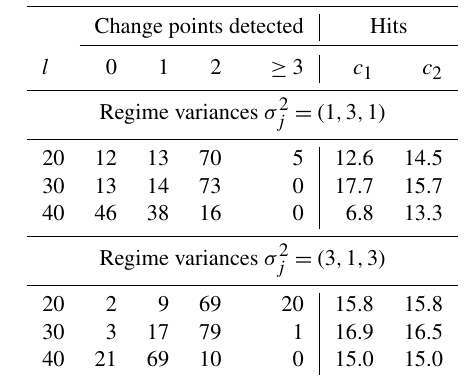
Figure 2. Percentage of hits as a function of the variance ratio be- /σ 2 tween two regimes ( σ 2 ) for different values of p in SRSD ( p , 2 1 30, 2). Table 2. Percentages of total numbers of change points detected by SRSD (0.1, l , 2) in each series on average and hits of the true change points c j = (31 ,